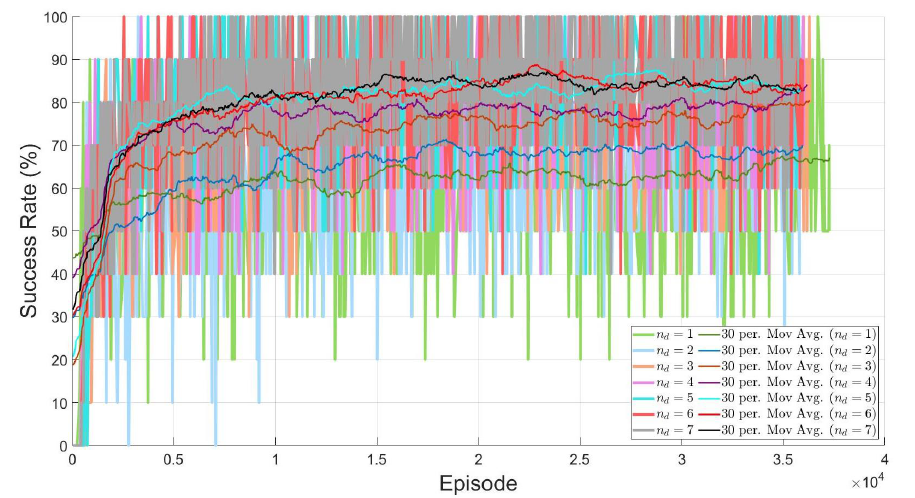
Figure 9. Comparison of the training performance between different numbers of